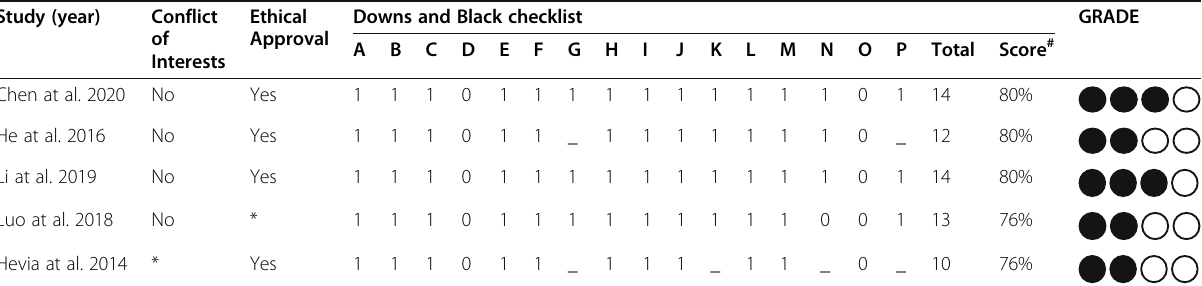
Table 1 Methodological quality assessment and strength of